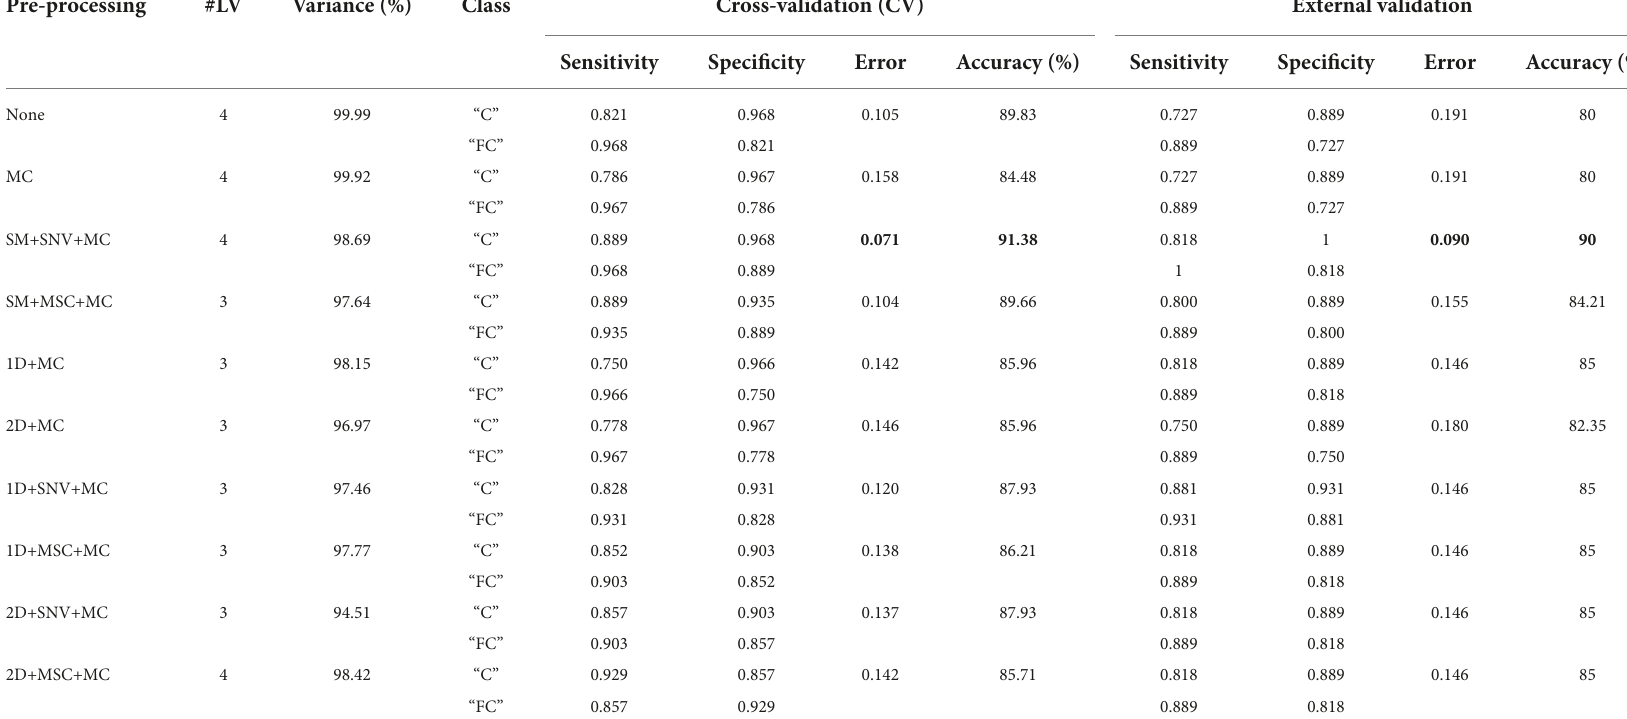
TABLE 4 PLS-DA results of classification based on the mean spectra of the CV and external validation datasets using different pre-processing combinations.